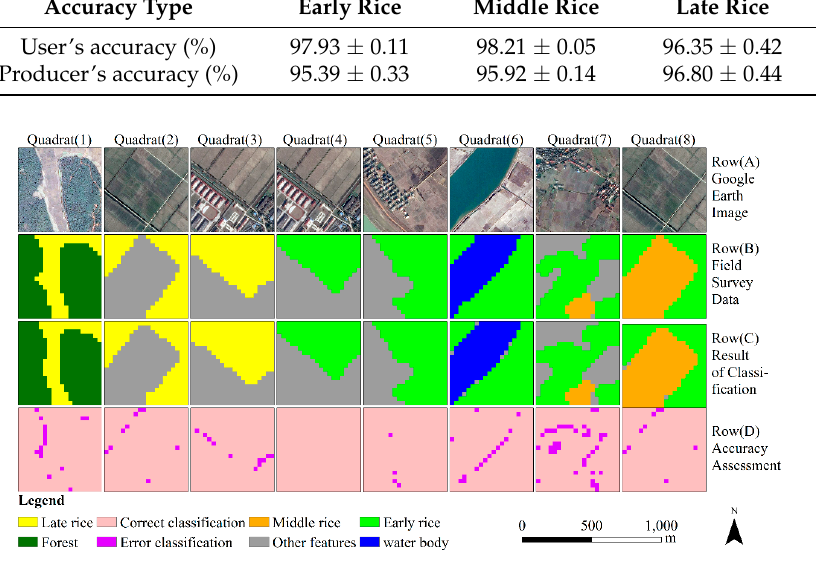
Figure 8. Accuracy assessment of extracted paddy rice information. Quadrats (1) to (8) (each 600 m × 600 m) were used to assess the classification accuracy of extracted paddy rice information. Row (A): Google Earth images from 2016 with 1 m spatial resolution. Row (B): Field survey data with 30 m spatial resolution that were used as ground truth data to assess result of classification. Row (C): Paddy rice classification results (including early, middle and late rice). Row (D): Accuracy assessment. Pink indicates correct classification, and purple indicates errors. Quadrats (2) and (8), (3) and (4) are the same quadrats, however, the sampling times are different.